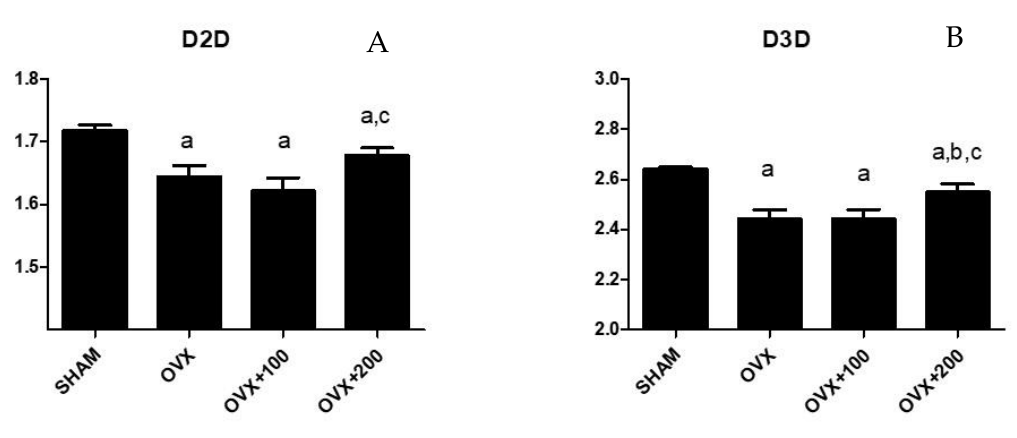
Figure 3. Fractal dimension analysis in 2D (D2D) ( A ) and in 3D (D3D) ( B ). SHAM operated, ovariectomized (OVX), ovariectomized and treated with olive oil (OVX + 100) (100 µ L / day by oral gavage) and ovariectomized and treated with olive oil (OVX + 200) (200 µ L / day by oral gavage) over 3 months, n = 12. Data are expressed as mean ± SD. Statistical significance: ( a ) vs. SHAM; ( b ) vs. OVX, ( c ) vs. OVX + 100. D2D: OVX vs. SHAM p < 0.01, OVX + 100 vs. SHAM p < 0.01, OVX + 200 vs. SHAM p < 0.05, OVX + 200 vs. OVX + 100 p < 0.05. D3D: OVX vs. SHAM p < 0.01, OVX + 100 vs. SHAM p < 0.01, OVX + 200 vs. SHAM p < 0.05, OVX + 200 vs. OVX p < 0.05, OVX + 200 vs. OVX + 100 p < 0.05.